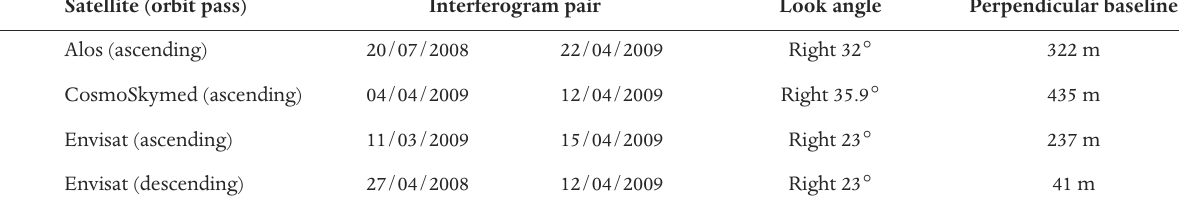
Table 2. Acquisition dates and interferometric parameters of the image pairs used in this study.